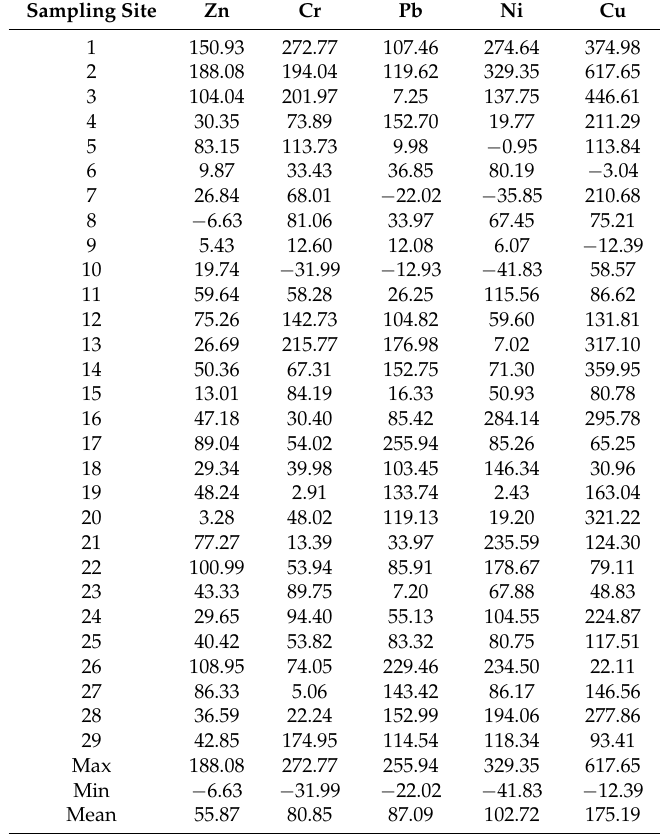
Table 4. The values of enrichment factors (EFs; %) for five heavy metals in bed sediment of NSAS.